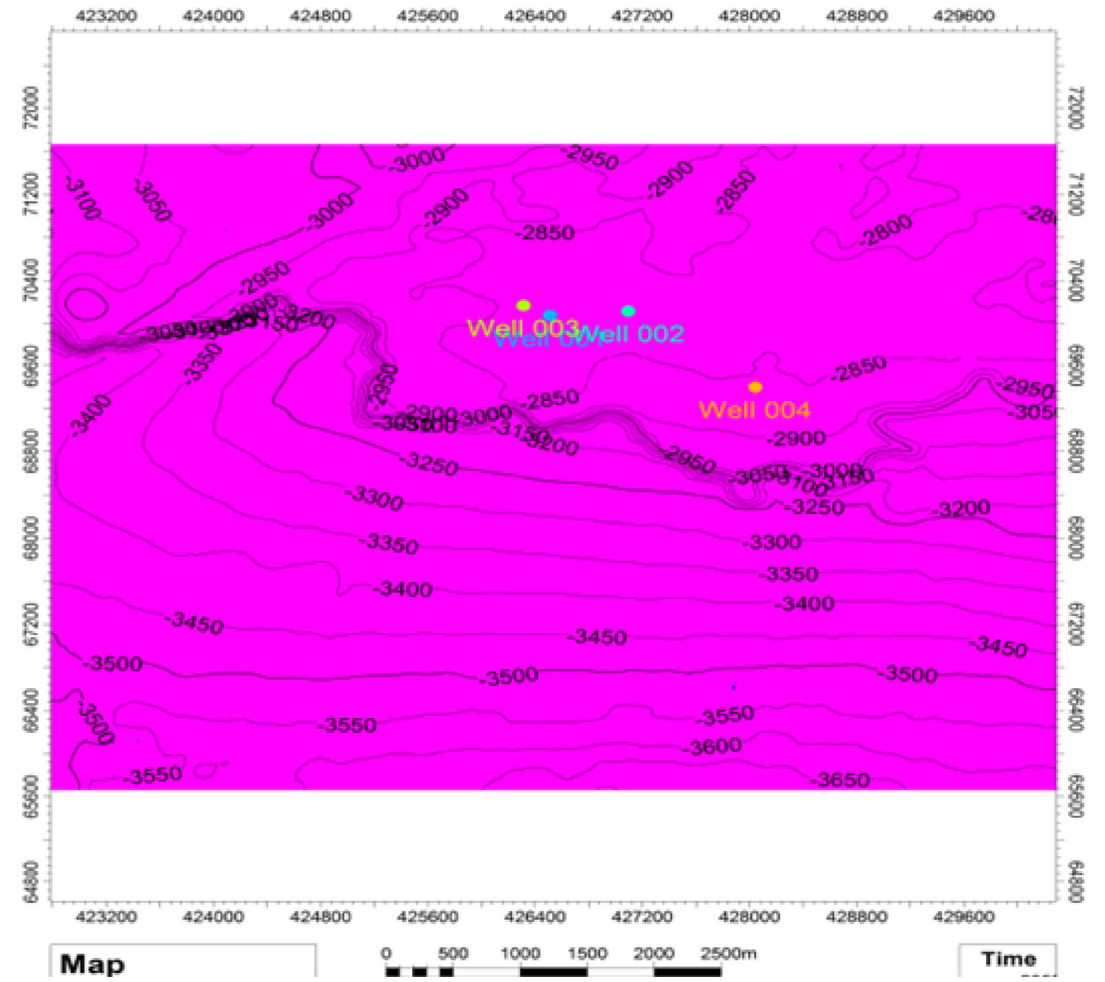
Fig. 9 Time map. This figure is the generated isochron map, indicating the position of the well location on the study